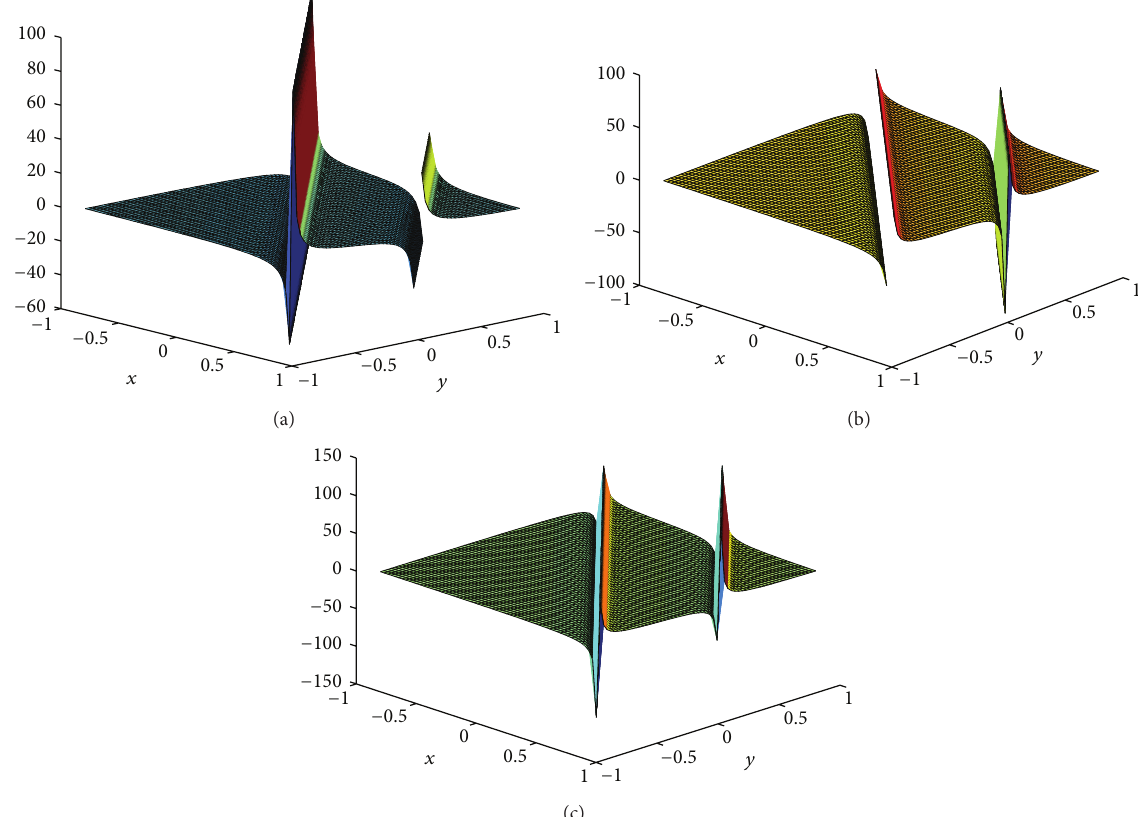
Figure 1: The solution of BLP corresponding to 𝑢 𝑟,2 : take 𝑐 = 1 , 𝜇 = 1 , 𝑧 0 = 0 , 𝑧 1 = 1 ; (a) 𝑡 = −1/100 , (b) 𝑡 = 0 , and (c) 𝑡 = 1/100 .